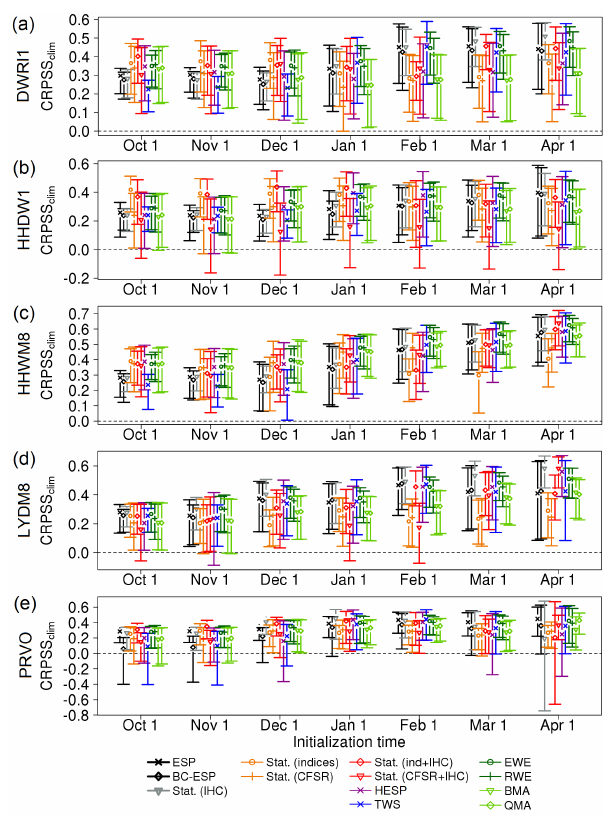
Figure 8. Continuous ranked probability skill score of the forecast ensembles with respect to mean observed climatology (CRPSS clim ). See text for further